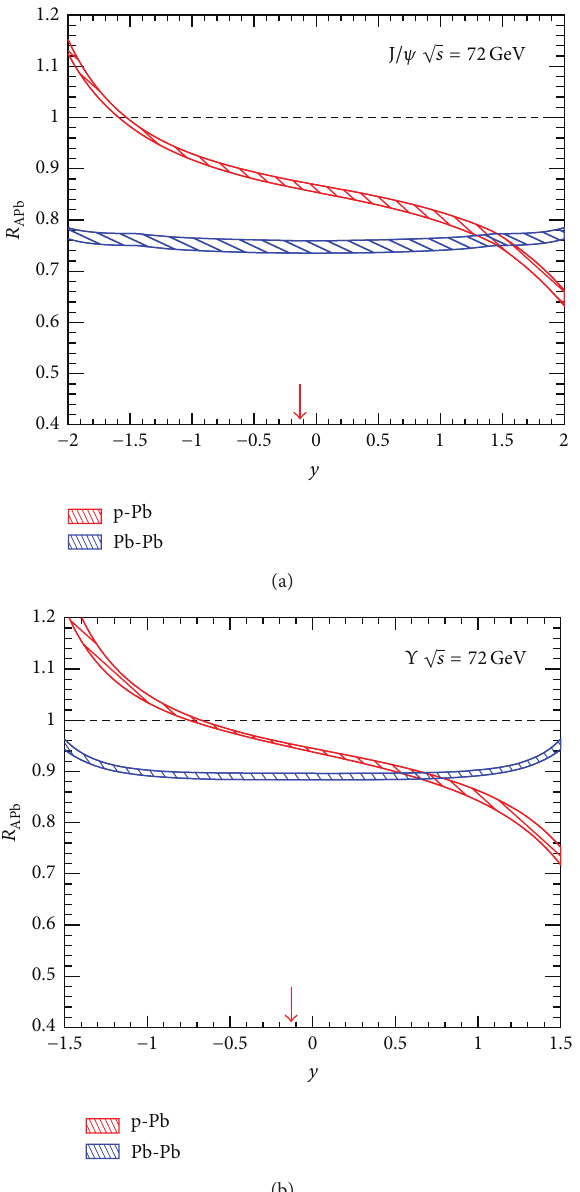
Figure2:J /𝜓 (a)and Υ (b)suppressioninp-PbandPb-Pbcollisions at √𝑠 =